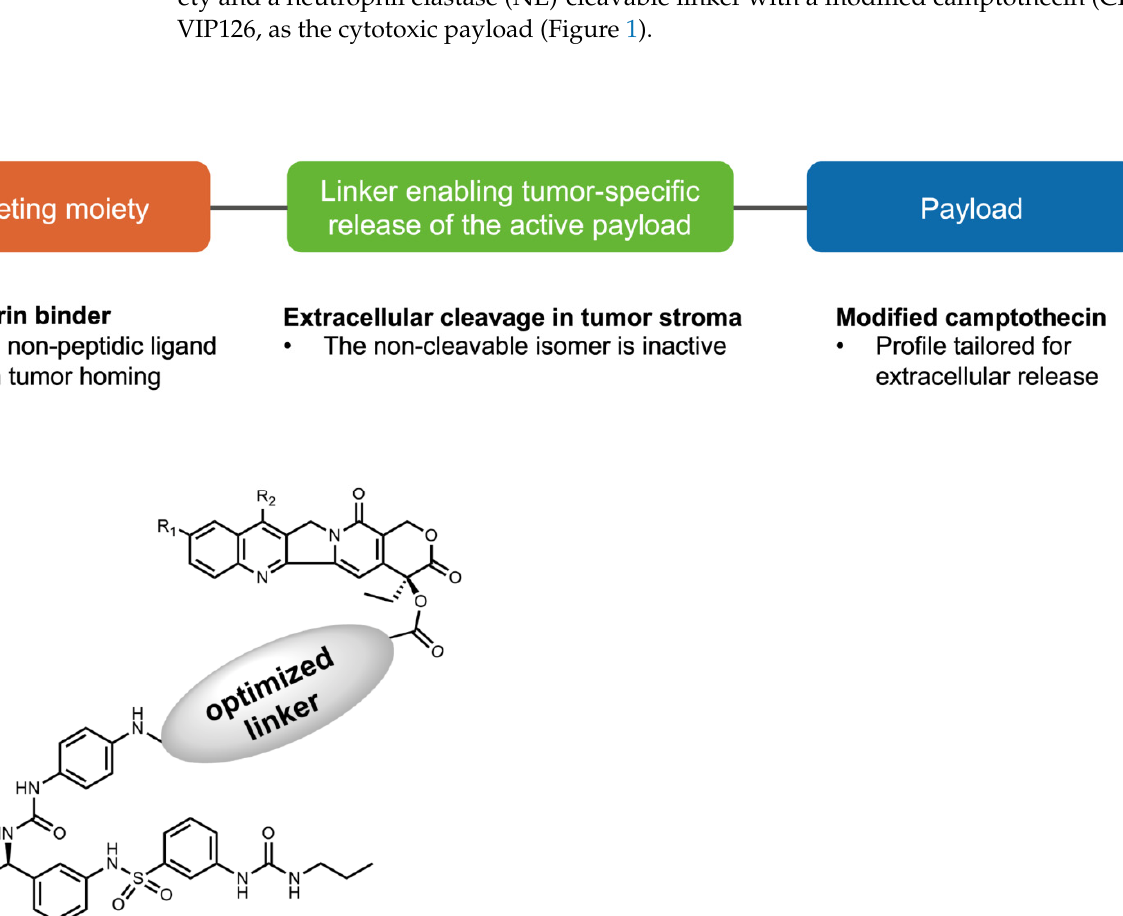
Figure 1. Structure of the small molecule–drug conjugate VIP236 . ( A ) The small molecule–drug conjugate (SMDC) VIP236 targets α V β 3 integrin, which is abundantly expressed on tumor cells. The VIP126 payload is specifically released by NE within the TME. ( B ) The generic chemical structure of VIP236.